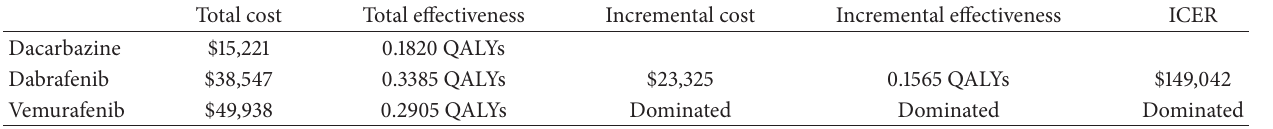
Table 2: Cost-effectiveness of dabrafenib relative to dacarbazine and vemurafenib relative to dabrafenib. Total cost Total effectiveness Incremental cost Incremental effectiveness ICER Dacarbazine $15,221